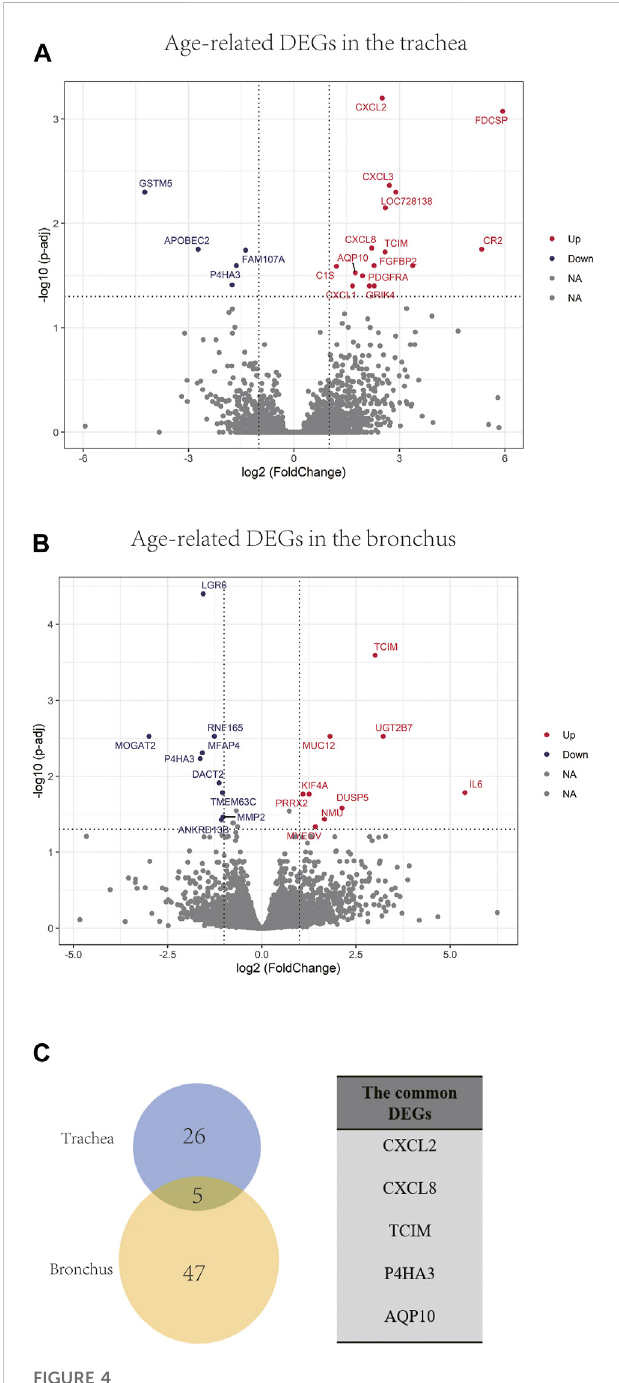
FIGURE 4 Age-related DEGs in the trachea and bronchus. (A) Volcano plot of age-related genes in the trachea. Genes with p.adj < 0.05 and at least 2- foldchange are labeled with gene symbols. (B) Volcano plot of age- related genes in the bronchus. Genes with p.adj < 0.05 and at least 2-foldchange are labeled with gene symbols. (C) Intersection of DEGs list in the trachea and bronchus and the list of common age-related genes in the trachea and bronchus.